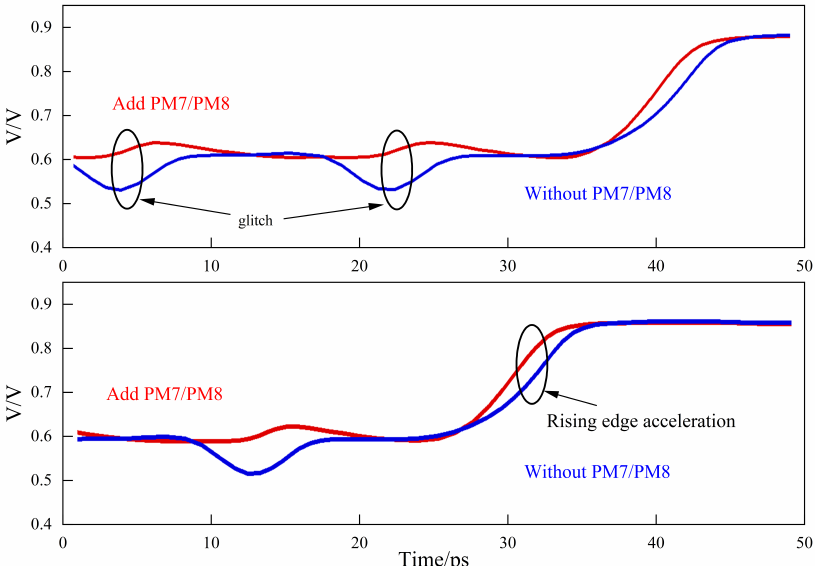
Figure 9. Simulation waveforms of output nodes with and without PM7/PM8.